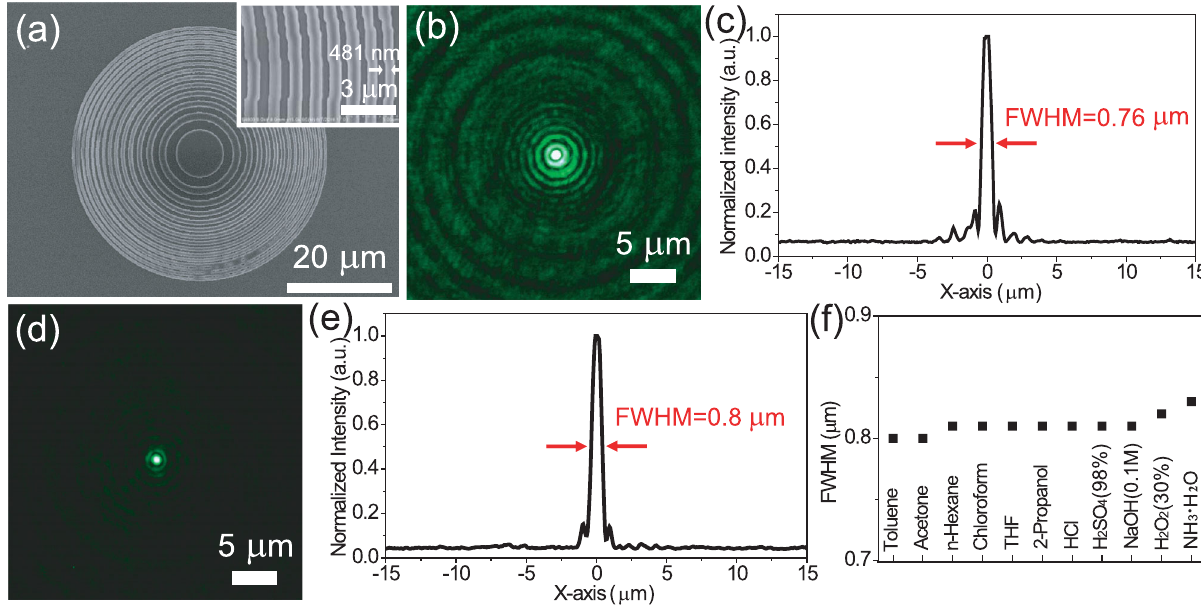
Fig. 7 Thermal and chemical resistance of HSQ Fresnel lens by FsLDW. a SEM image of the HSQ Fresnel lens microstructure by FsLDW. The inset is the magni fi ed SEM image. b The microscope focusing image of the HSQ Fresnel lens. c The intensity distribution collected along the x -axis direction shown in b . d The microscopic focusing image of the HSQ Fresnel lens after heating at 400 °C for 0.5 h. e The intensity distribution collected along the x -axis direction shown in d . f Full-width at half maximum (FWHM) of the optical intensity pro fi le along x -axis of the focusing spot of HSQ Fresnel lens after being exposed to different chemical reagents, which are selected to imitate harsh